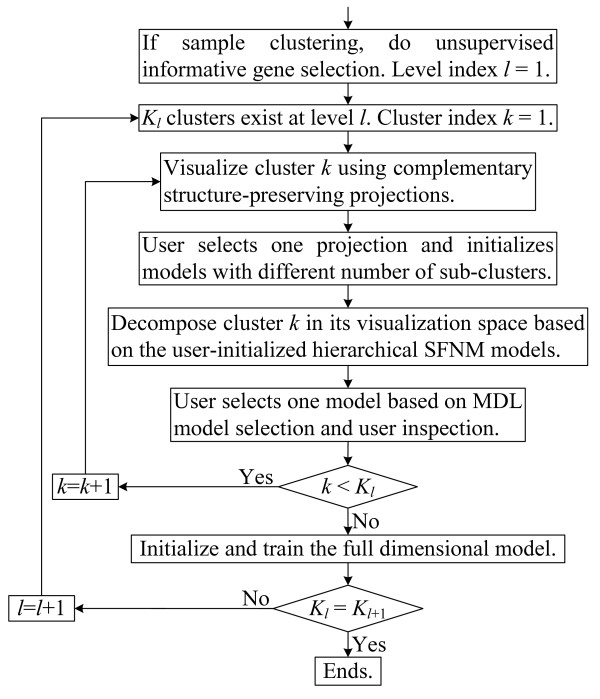
VISDA's flowchart.